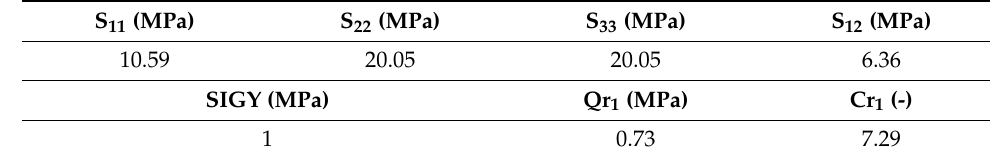
Table 6. Hill’s and Voce’s parameters of the fully optimized simulation.